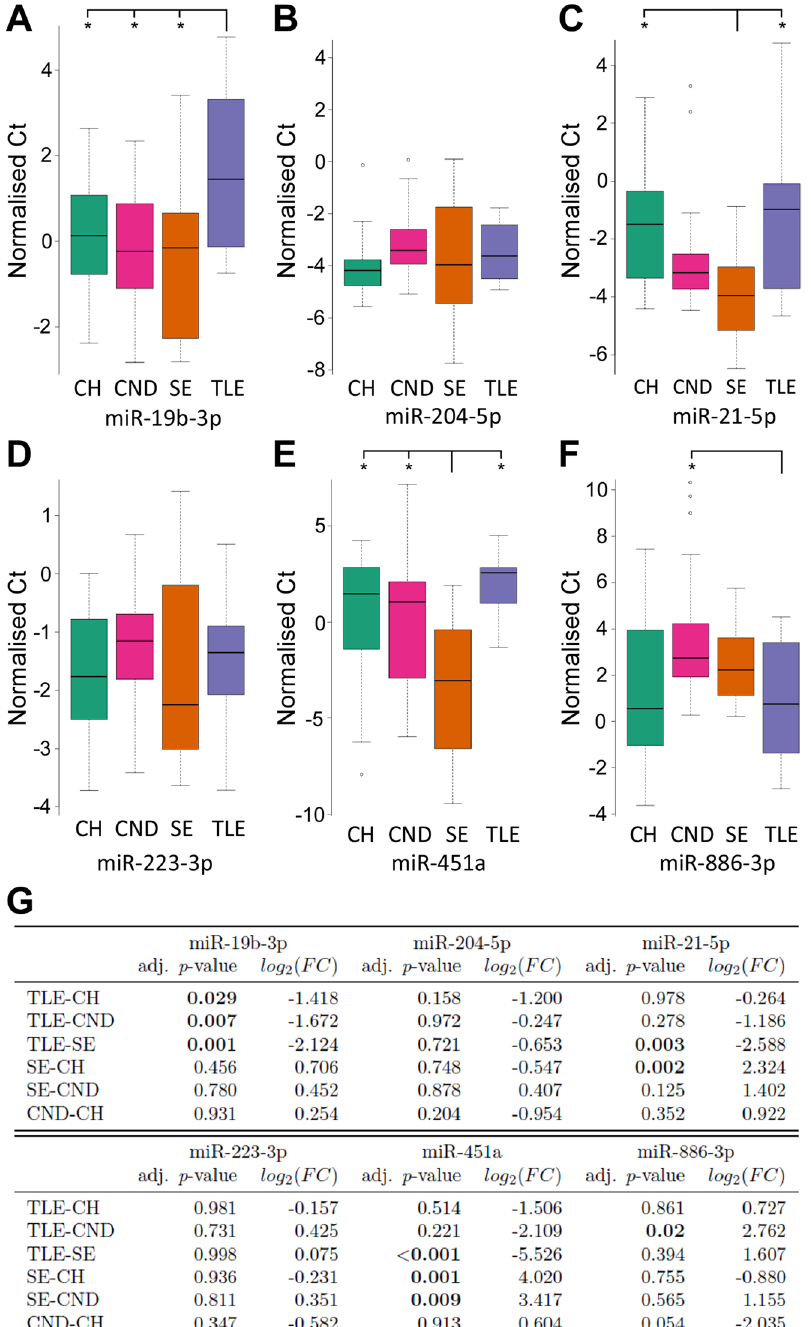
Figure 2. Validation of microRNA. ( A – F ) Boxplots showing the distribution of normalised Ct following Taqman individual microRNA assays of miR-19b-3p, miR-21-5p, miR-204-5p, miR-223-3p, miR-451a and miR- 886-3p in each of the four sets of samples: CH (N = 25), CND (N = 25), SE (N = 16) and TLE (N = 14). Note, the data shown are normalized and the lower the value the greater the relative expression of the microRNA. Outliers not graphed for purposes of data presentation are shown as circles. ( G ) log 2 (FC) and adjusted p -value for validated microRNA. CH: controls with headache, TLE: temporal lobe epilepsy, SE: status epilepticus, CND: controls with other neurological